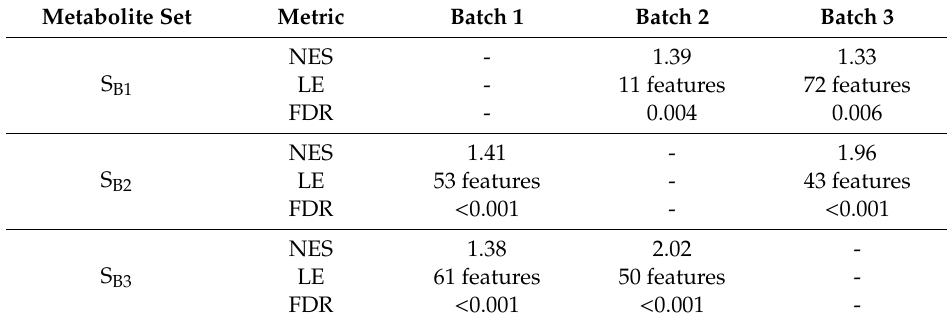
Table 2. Enrichment analysis applied to three metabolomics datasets following exposure of C. reinhardtii to chlorobenzene in independent experiments (batches 1, 2, 3). Ranked lists of m / z feature LFC were calculated (S B1 –S B3 for batches 1–3) and every list was compared against every other list to determine whether S B1 -S B3 were enriched with elements of the other sets. Significance of enrichment was assessed using 1000 random permutations of m / z values in LFC-ranked lists, and false-discovery rates are reported. NES = normalised enrichment score, degree of metabolite enrichment of S within dataset.